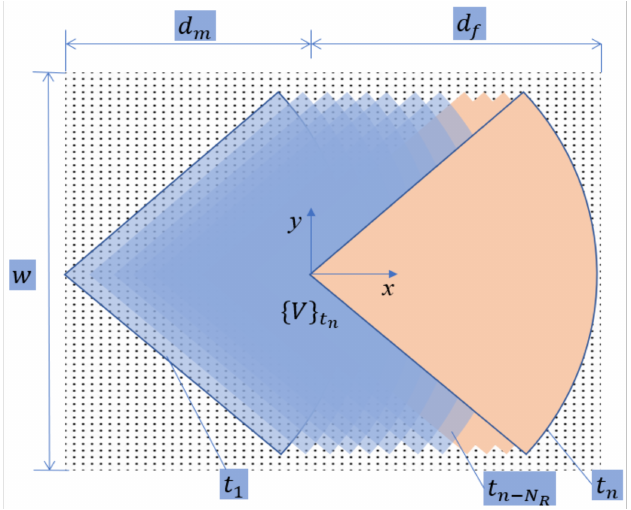
Figure 8. Measuring the range of the depth camera in the designated mapping